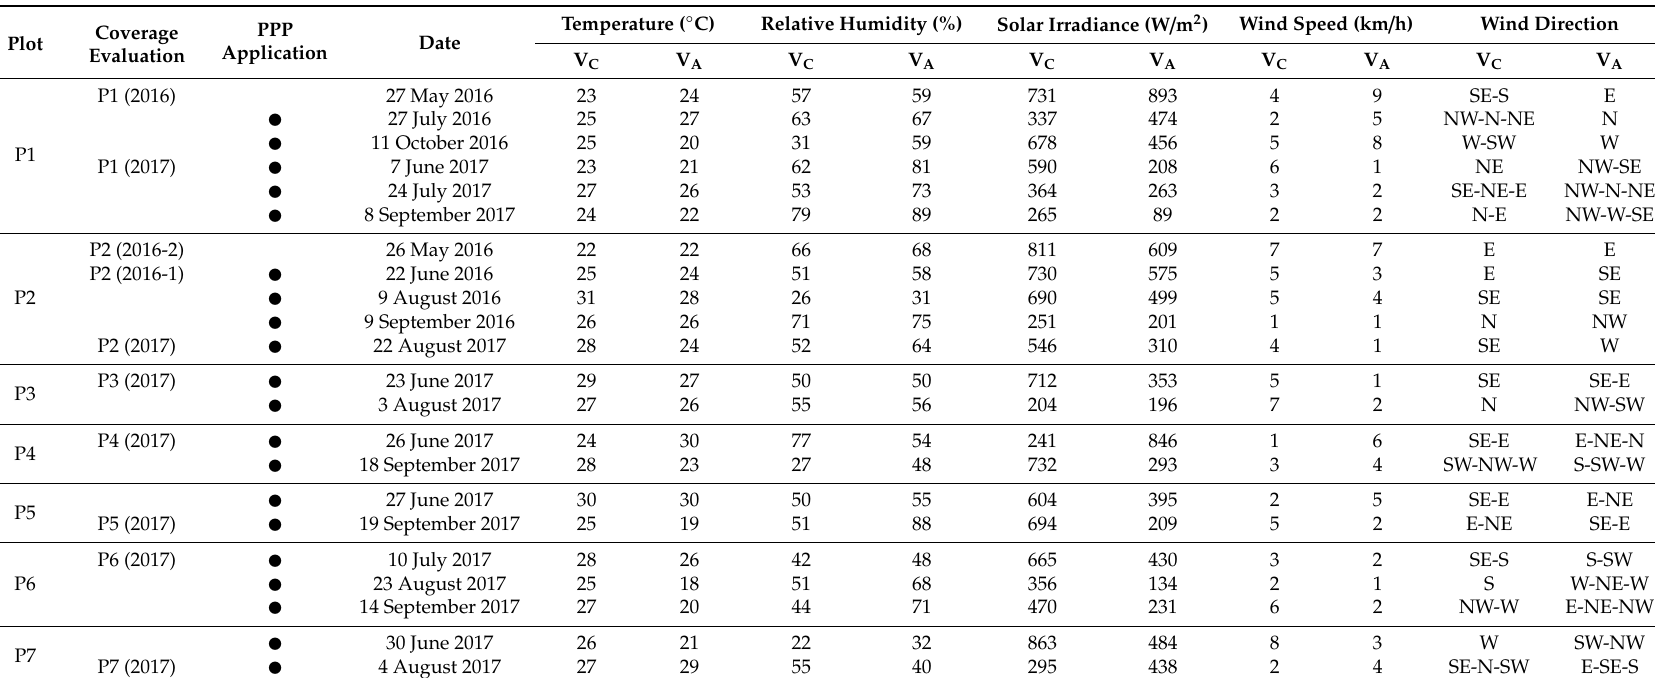
Table A1. Meteorological conditions during the PPP applications and coverage evaluations. The precipitation was 0 mm in all cases, except for P4 26 June 2017 V A , where it was 0.02 mm. The meteorological conditions were taken from the weather stations of the Spanish SIAR (“Servicio de Informaci ó n Agroclim á tica para el Regad í o”, Agroclimatic Information Service for Irrigation) network